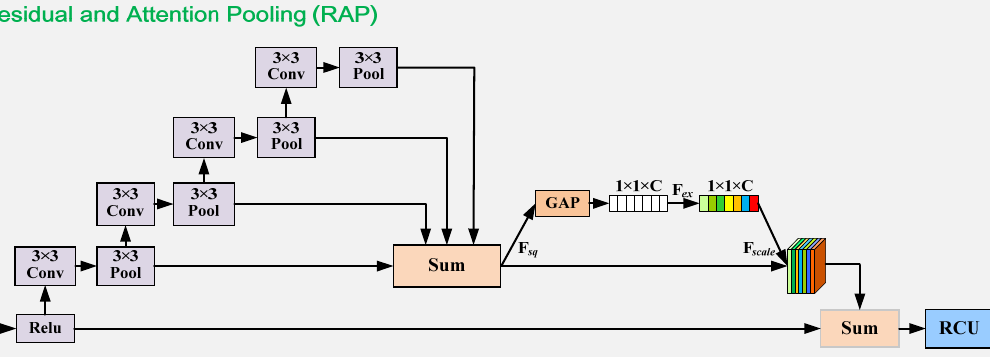
Figure 2. The Feature Map Adaption and Fusion (FMAF) architecture.